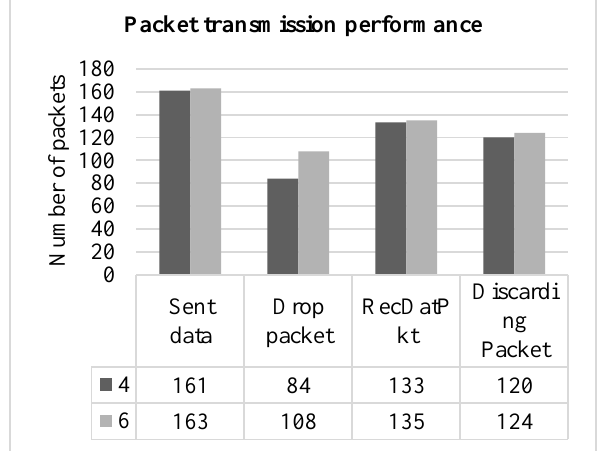
Figure 2 Packet transmission